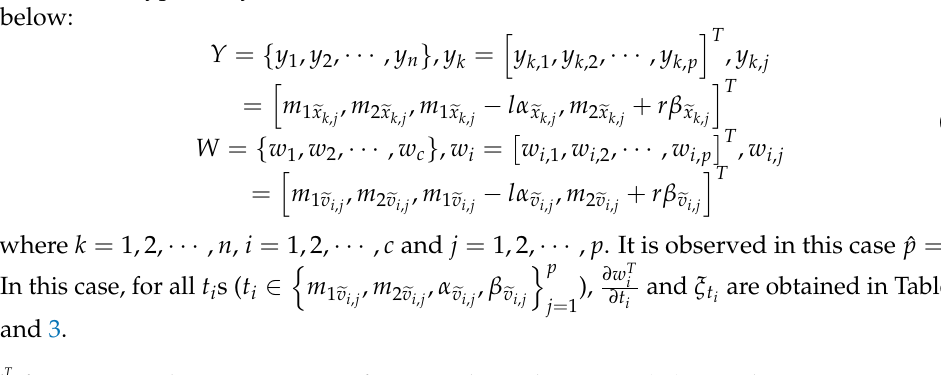
Table 2. ∂ w T for VFCSS applying over LR-type fuzzy numbers when metric (13) is used. ∂ t